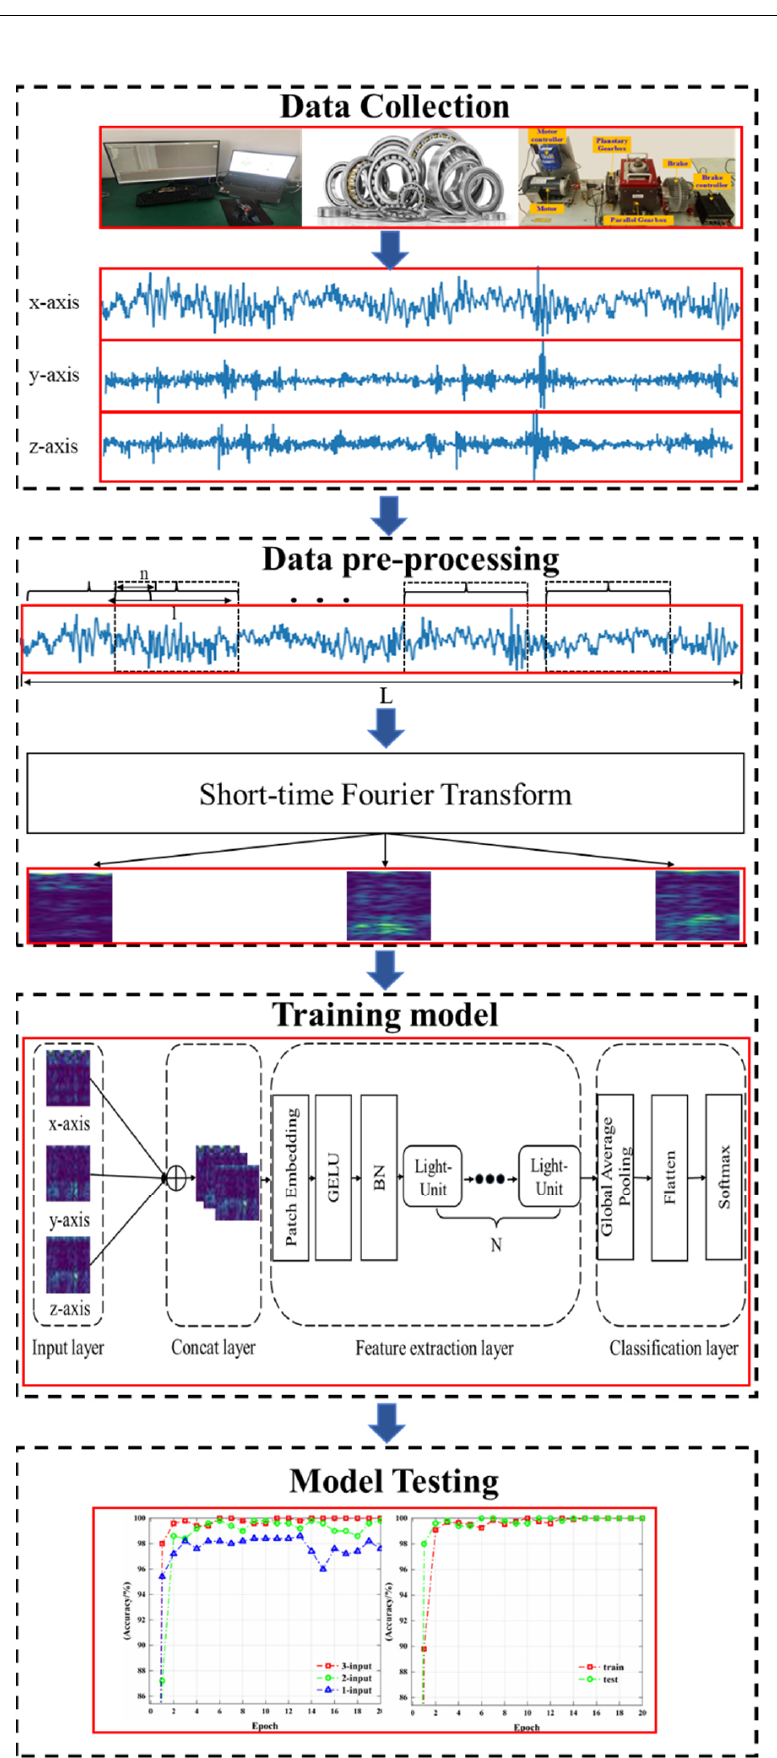
Figure 6. Specific process of fault diagnosis using multi-directional vibration signals.